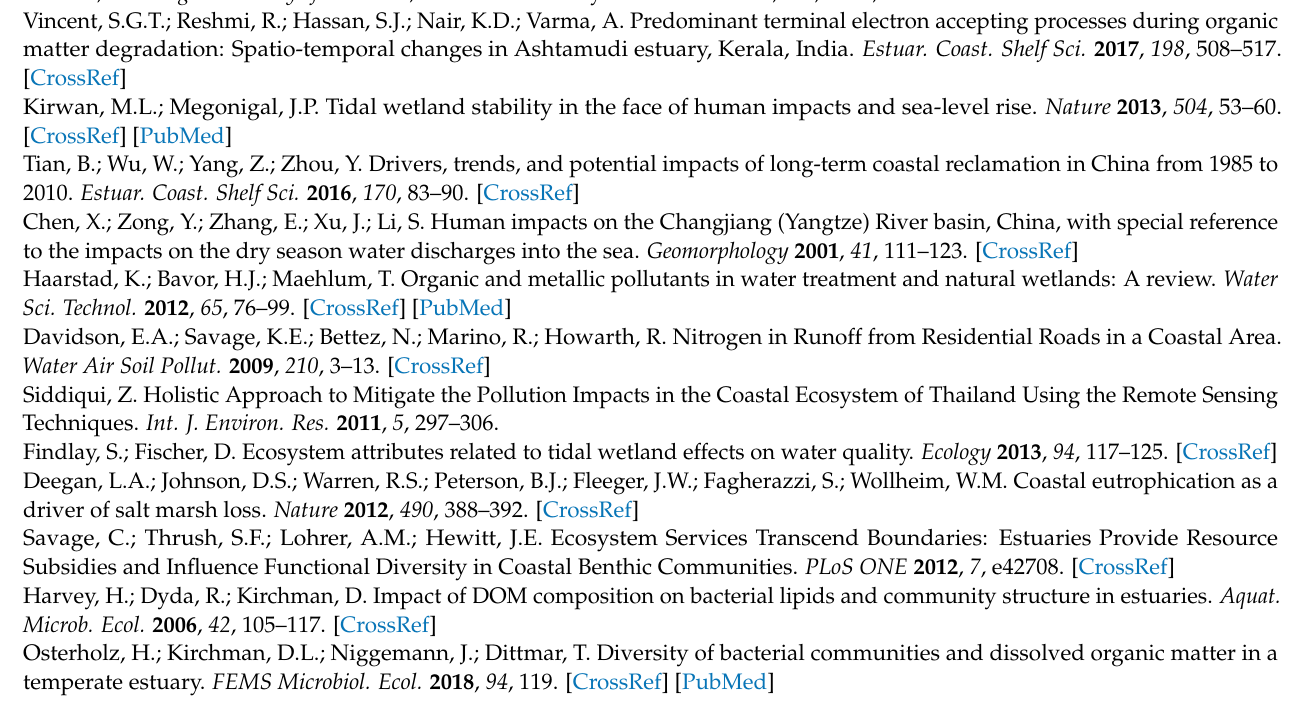
Table S2: Spearman correlation analyses between functional group abundance quantification (qPCR) and the physicochemical variables